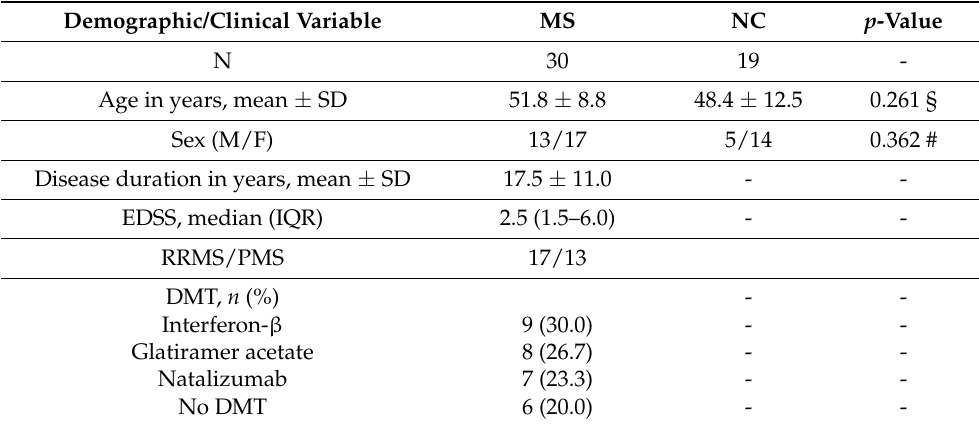
Table 1. Demographic and clinical characteristics of the two groups.